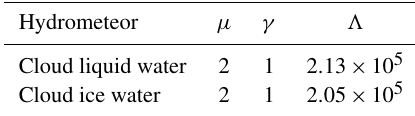
Table 2. Parameters used for the modified gamma